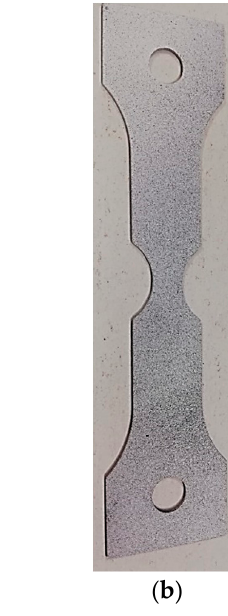
Figure 15. ( a ) Experimental equipment for uniaxial tensile tests; ( b ) Notched specimen with speckle-pattern.